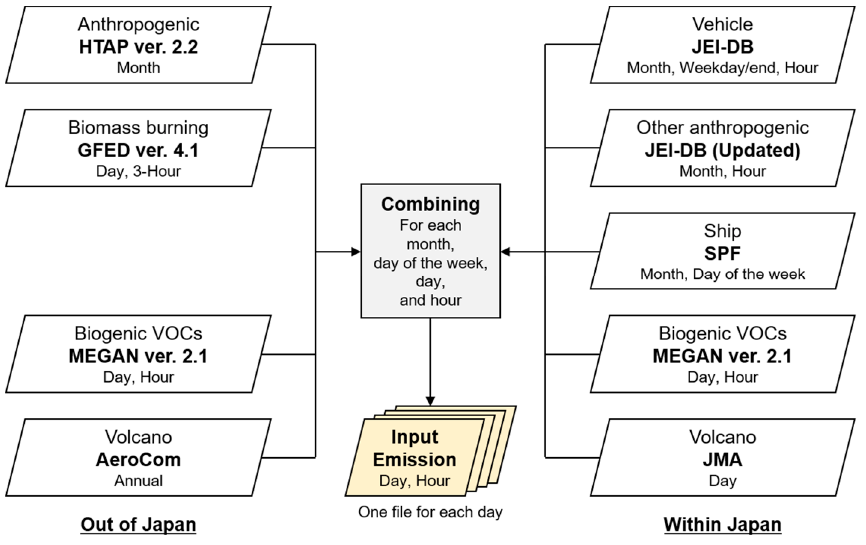
Figure 2. Schematics of all the emission data and the flow used to prepare a single input emission file for each